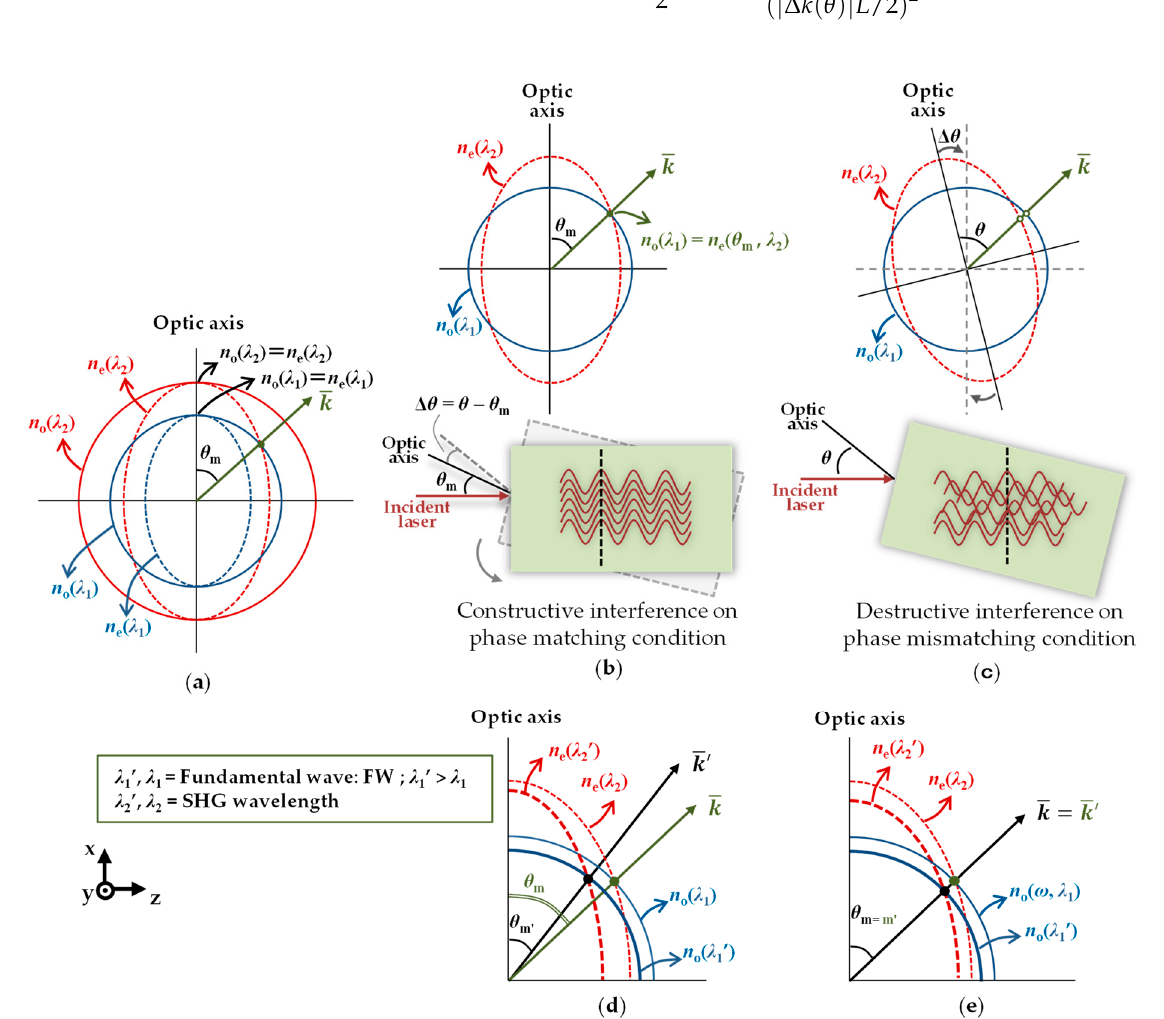
Figure 2. ( a ) Two-dimensional perspective of the refractive indices surface for type I negative uniaxial crystal; ( b ) phase matching condition; ( c ) phase mismatching condition; ( d ) the change on refractive indices’ surface followed by the change of phase-matching angle; ( e ) the change of refractive indices’ surface with the same phase-matching angle in a certain range of wavelengths.